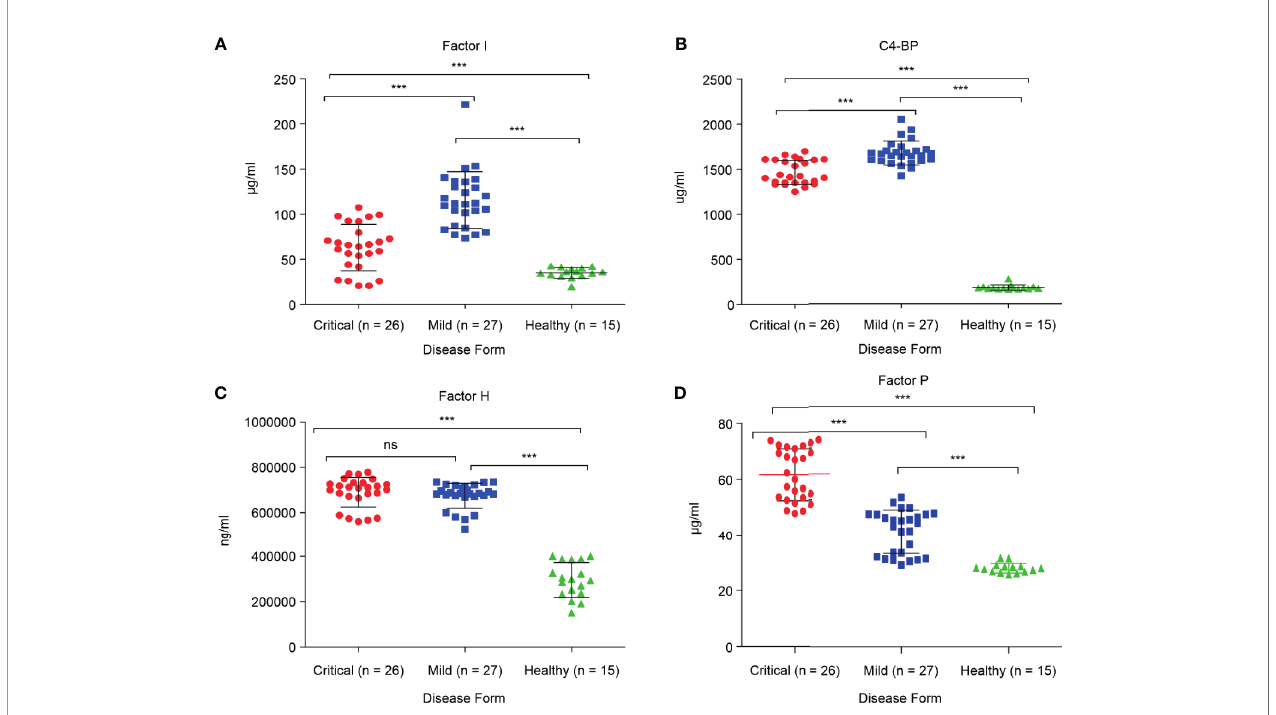
FIGURE 2 | Serum concentrations of complement factors in the critical and mild COVID-19 patients, and healthy controls. Concentrations of (A) factor I; (B) factor C4-BP; (C) factor H; and (D) factor P. ANOVA and Tukey ’ s multiple comparison test were used for statistical comparisons. *** p < 0.001 and ns p >